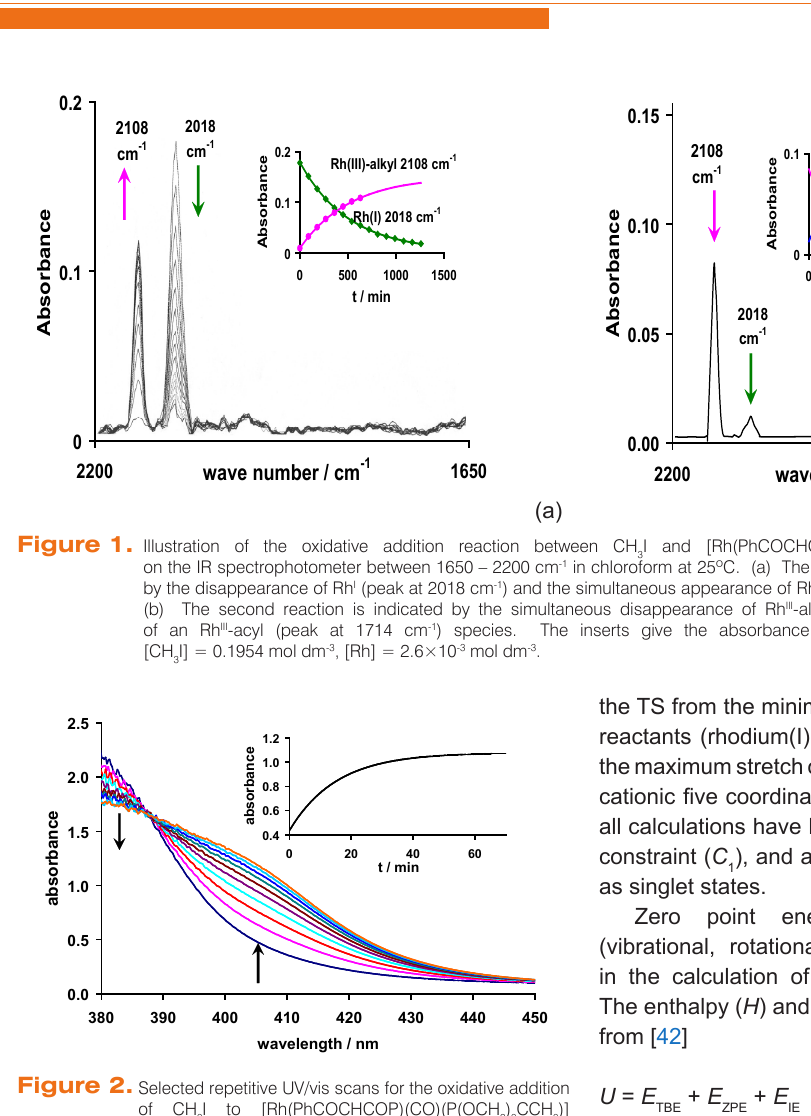
) CCH )] 2 3 3 I] = 0.1040 mol dm -3 , 3 = 0.0011092(3) s -1 obs